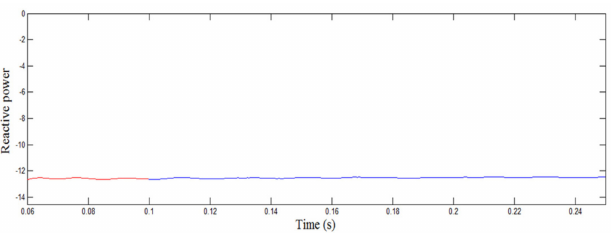
Figure 27. Reactive power from the bidirectional converter.